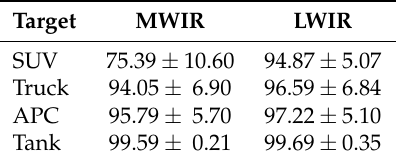
Table 3. The fusion results with three robots and different types of